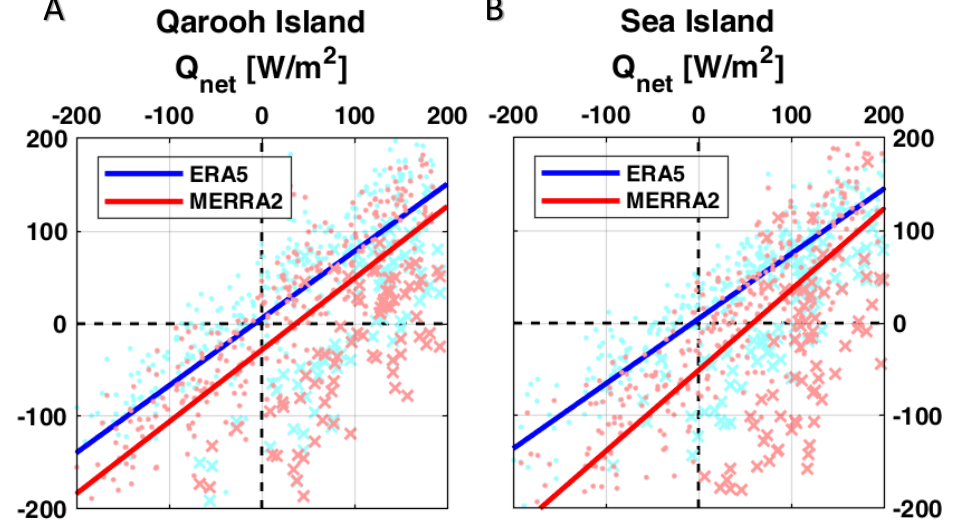
Figure 9. Comparison of daily net heat fluxes (January-2013 to March-2014) from reanalysis products with observations at ( A ) Qarooh Island and ( B ) Sea Island. A linear fit to the data, using robust regression, is represented by the solid lines. The summer period (June–August) is marked by